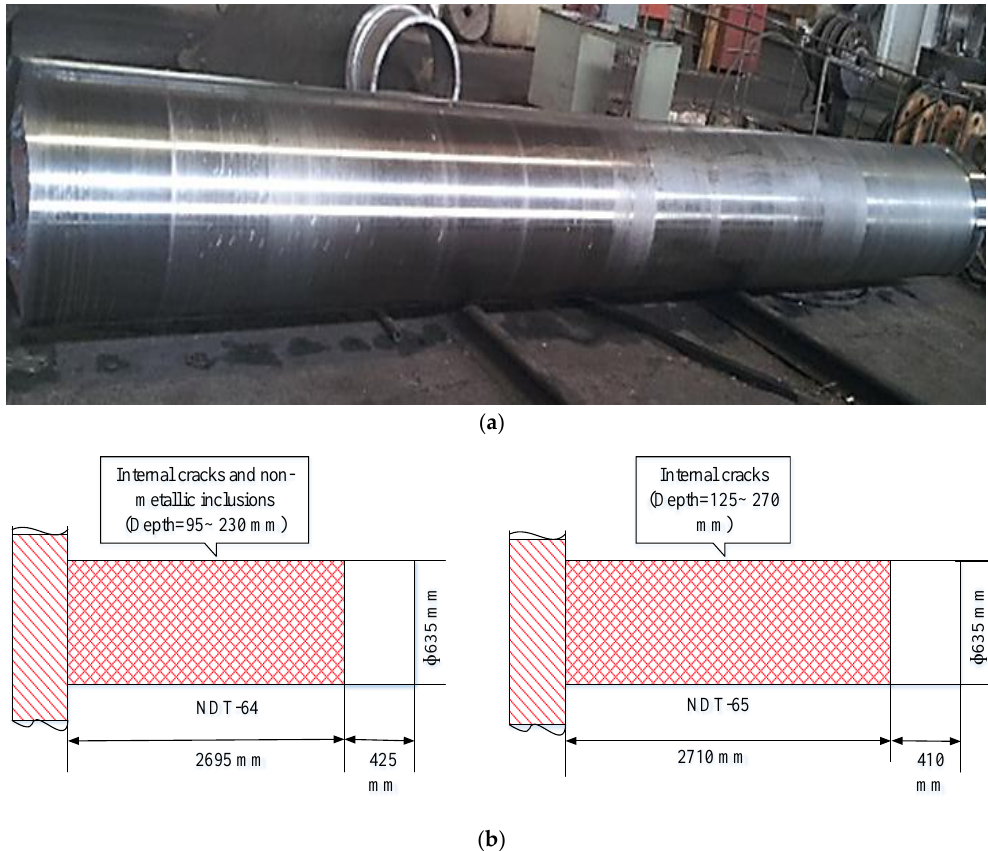
Figure 7. ( a ) A rough machined shaft that was rejected after UT inspection; ( b ) UT report locating internal cracks and foreign particle inclusions under duplicate